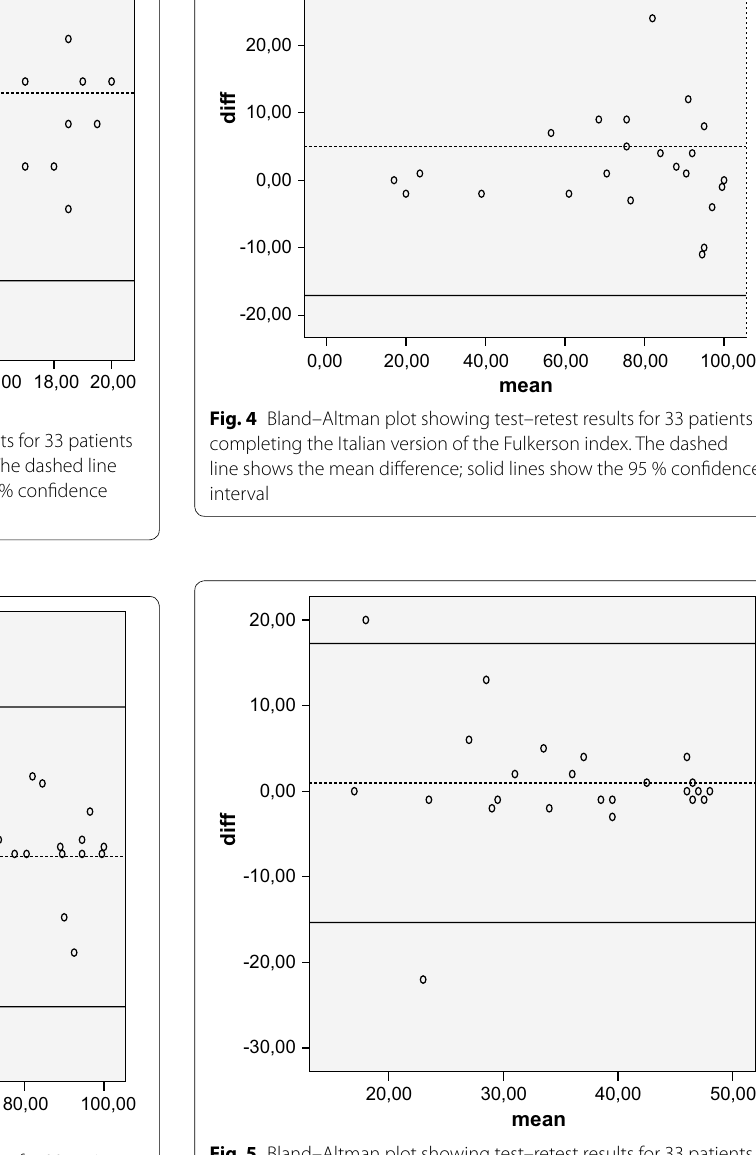
score, 1.1 for the Larsen score, and 1.1 for the Lysholm score (Table 1). SRM > 0.8 is generally considered to be excellent.